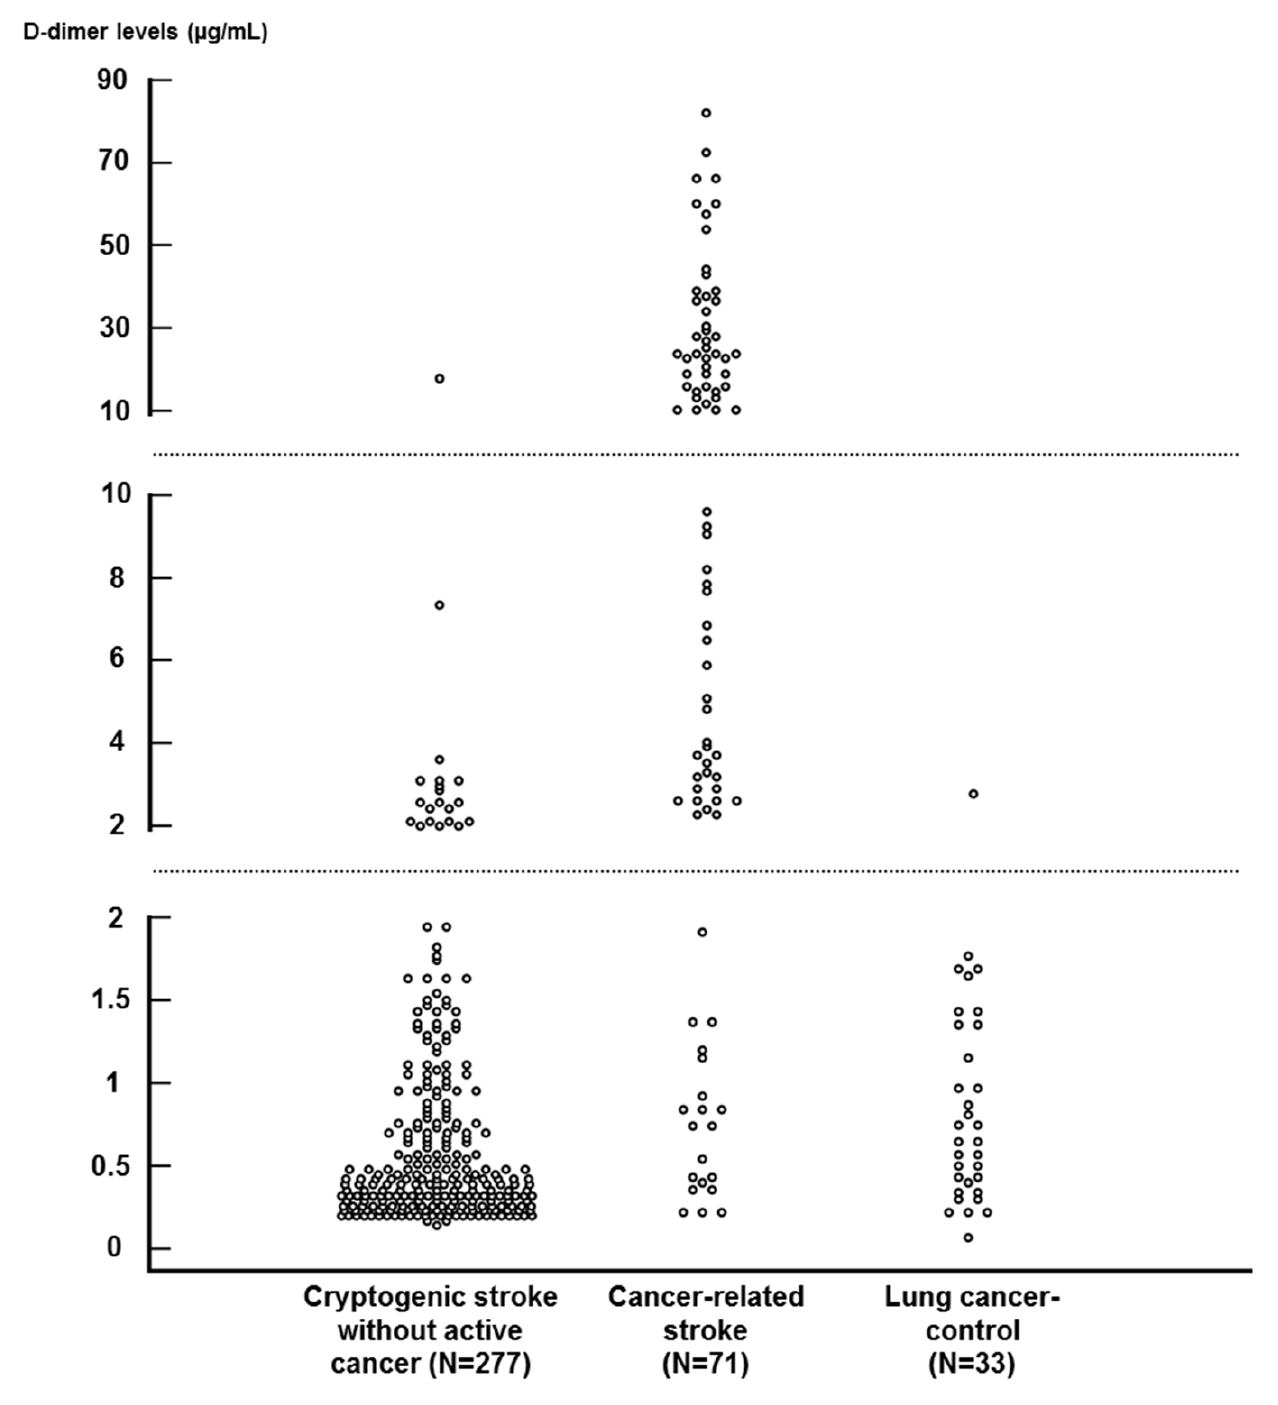
Figure 2. Distribution of plasma D-dimer levels in patients with cancer-related stroke (N=71), cryptogenic stroke without active cancer (N=277), and active lung cancer without a history of stroke (N=33). D-dimer levels were significantly higher in the cancer-related stroke group than in the cryptogenic stroke without active cancer or lung cancer-control groups (both P , 0.001).